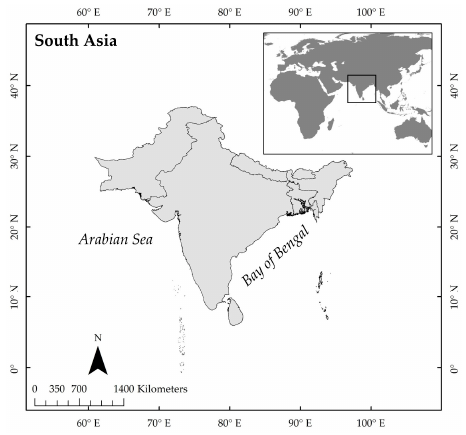
Figure 1. South Asian countries included in the analysis.